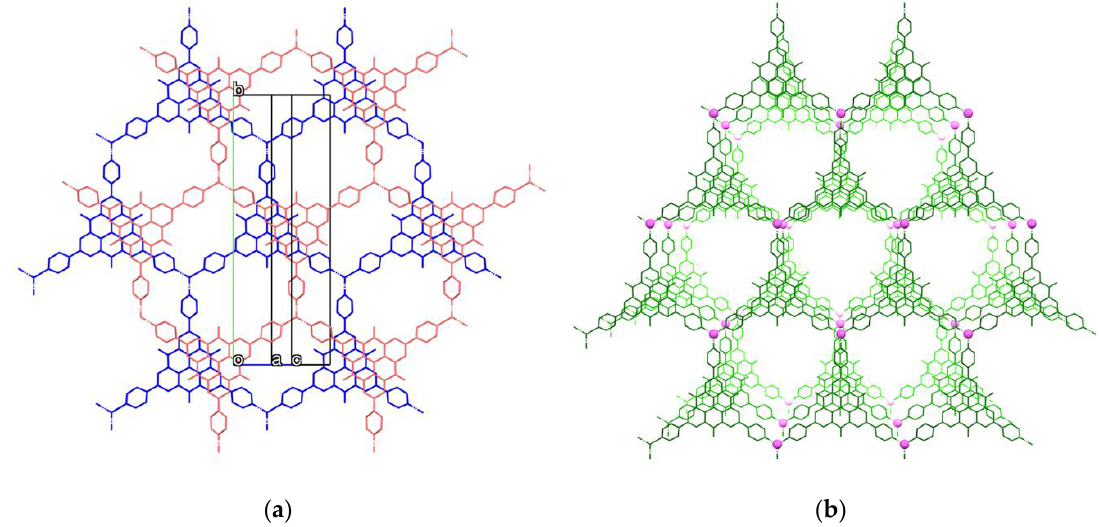
Figure 8. ( a ) Overlap view of the 2D coordination sheet in 5 . The red sheet is on the upper side, and the blue one is on the lower side. ( b ) A model packing structure with a large 1D channel designed by ideally parallel stacking of a 2D coordination sheet in 5 . The green molecular skeletons represent 4 species, and the magenta balls are metal ions. The sheets on the lower side are drawn in lighter